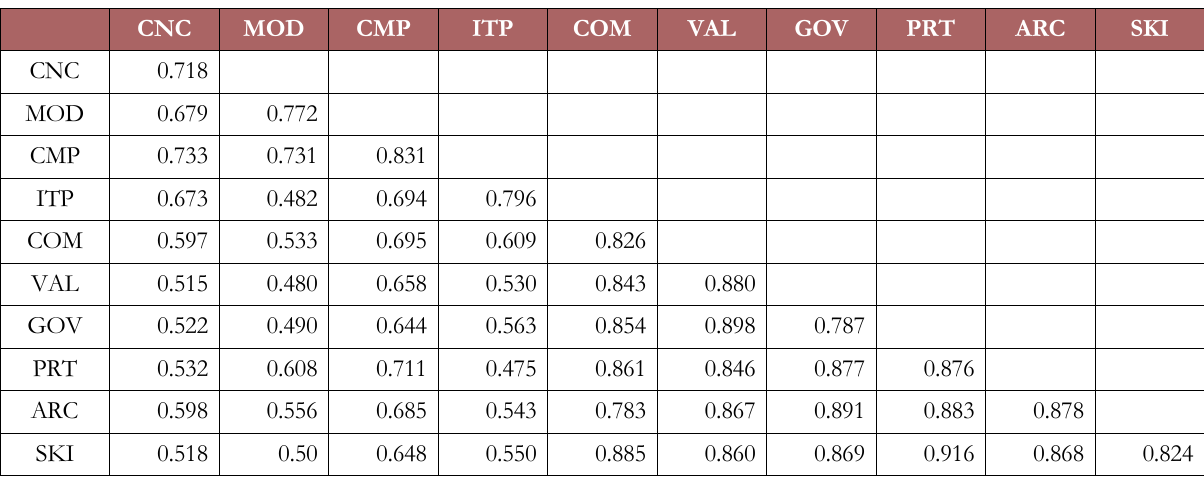
Table 4. Square-rooted AVE and latent variable correlations (before indicators